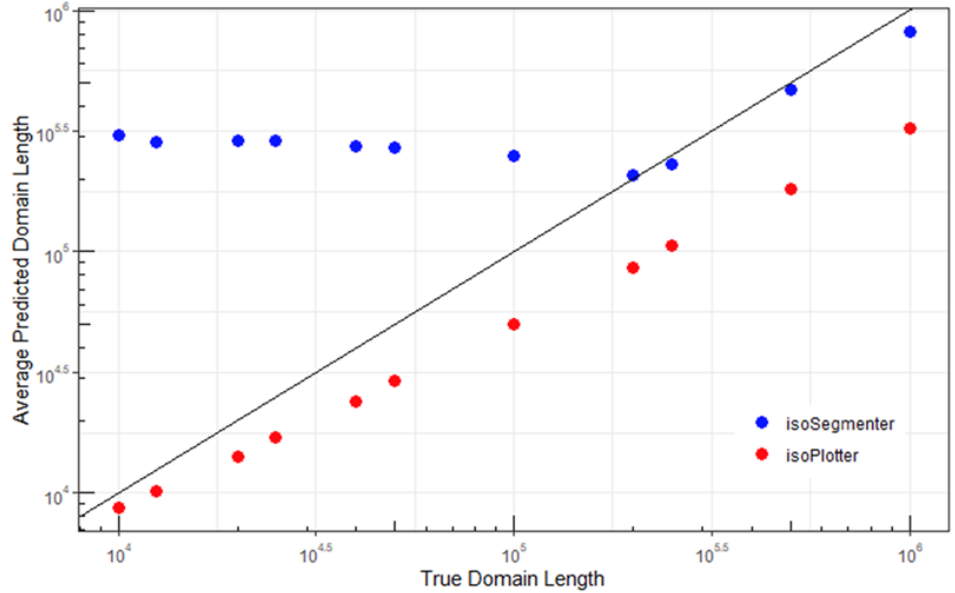
Figure 4. Comparison of average predicted domain lengths for isoPlotter and isoSegmenter to the actual domain lengths in the equal-domain-length simulated sequences.